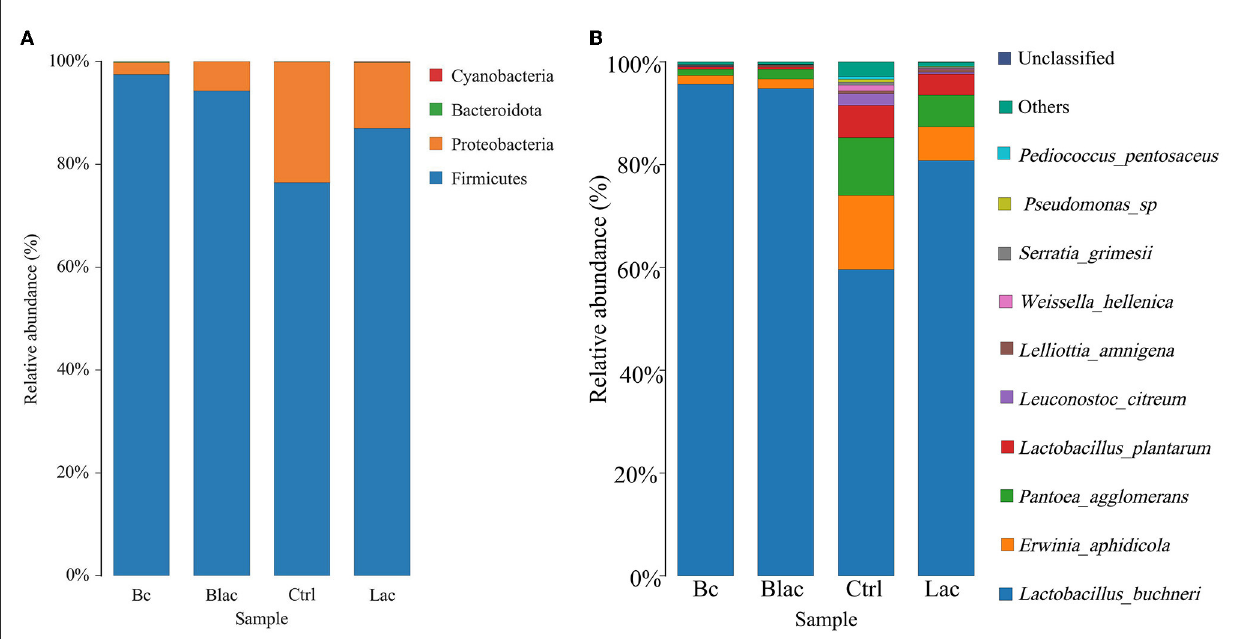
FIGURE5 Distribution of microorganisms at the phylum level (A) and the species level (B) ; Bc, added with strain B. cereus AH7-7; Blac, added with strain B. cereus AH7-7, Lactobacillus plantarum and Lactobacillus buchneri ; Lac, added with Lactobacillus plantarum and Lactobacillus buchneri ; Ctrl, no additives.